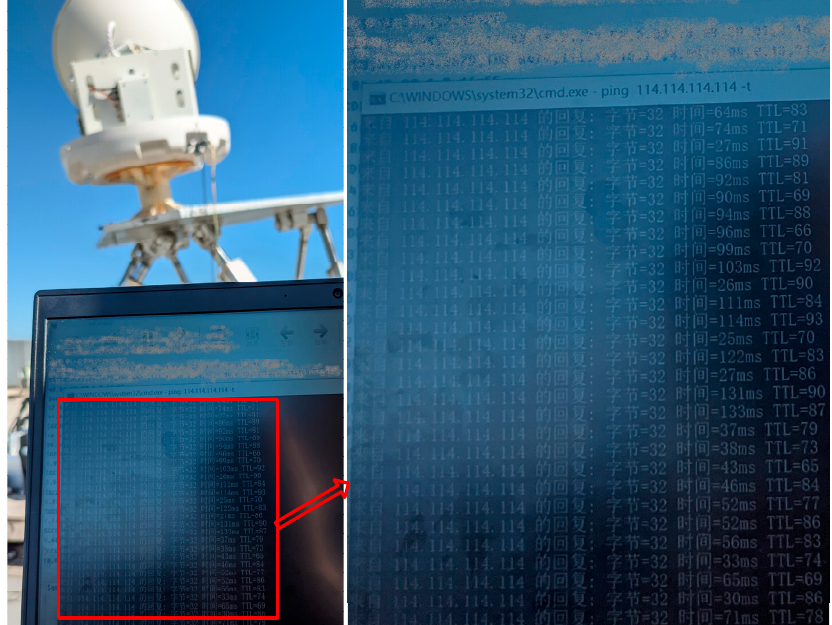
Figure 8. Network communication via SOTM.